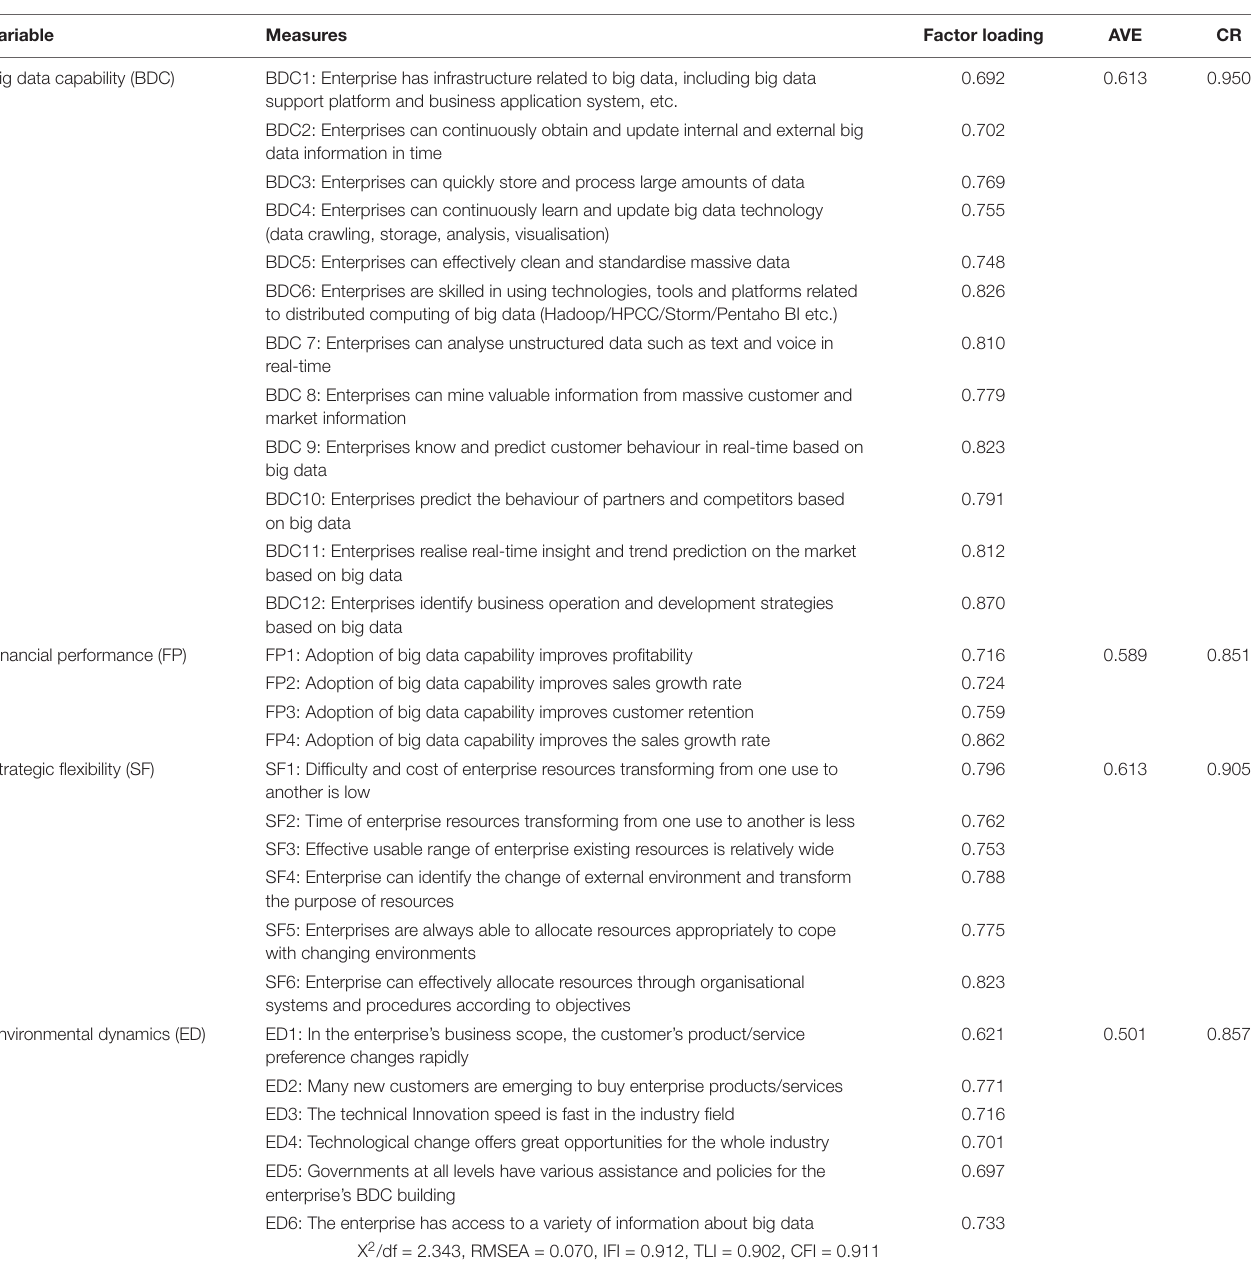
TABLE 2 | Assessment of reliability and validity of reflective constructs.